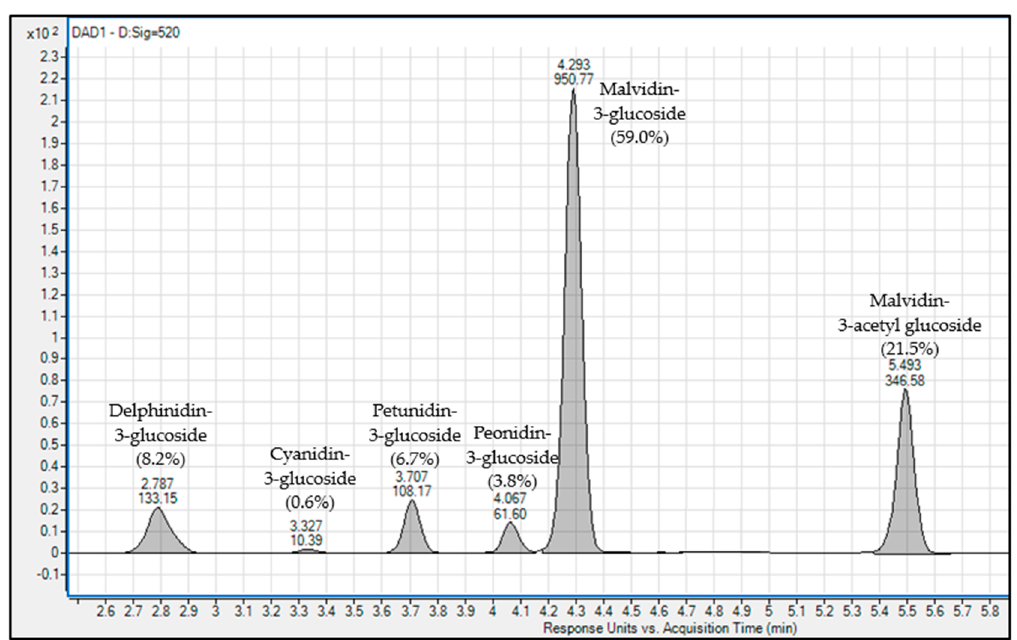
Figure 9. Chromatogram (520 nm) of anthocyanin in control samples. Peaks identify the six monomeric anthocyanins found in the purified anthocyanin material and their relative abundance within the mixture (quantified in “Malvidin Equivalents”).